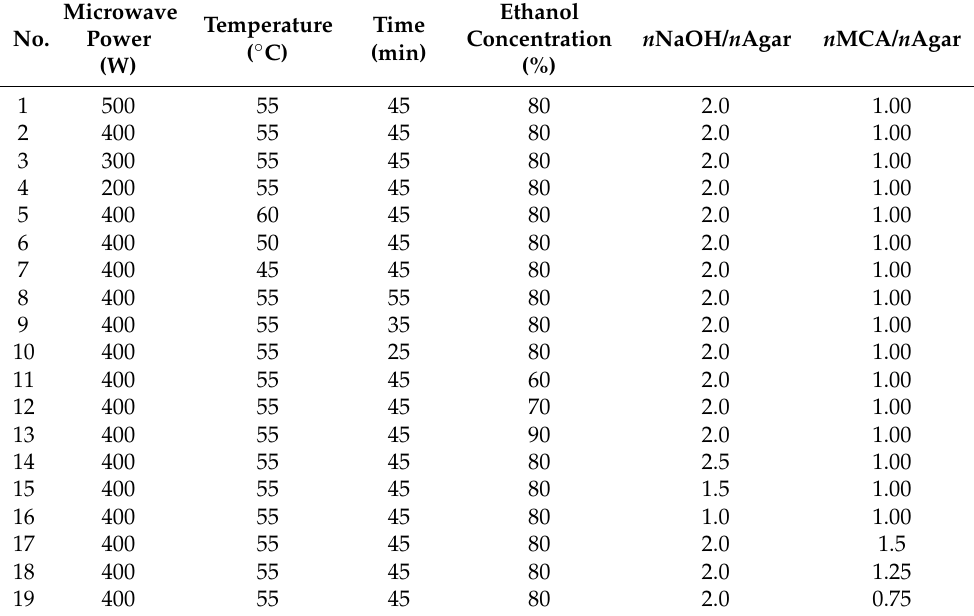
Table 5. Single-factor tests of the microwave-assisted synthesis of carboxymethyl agar.